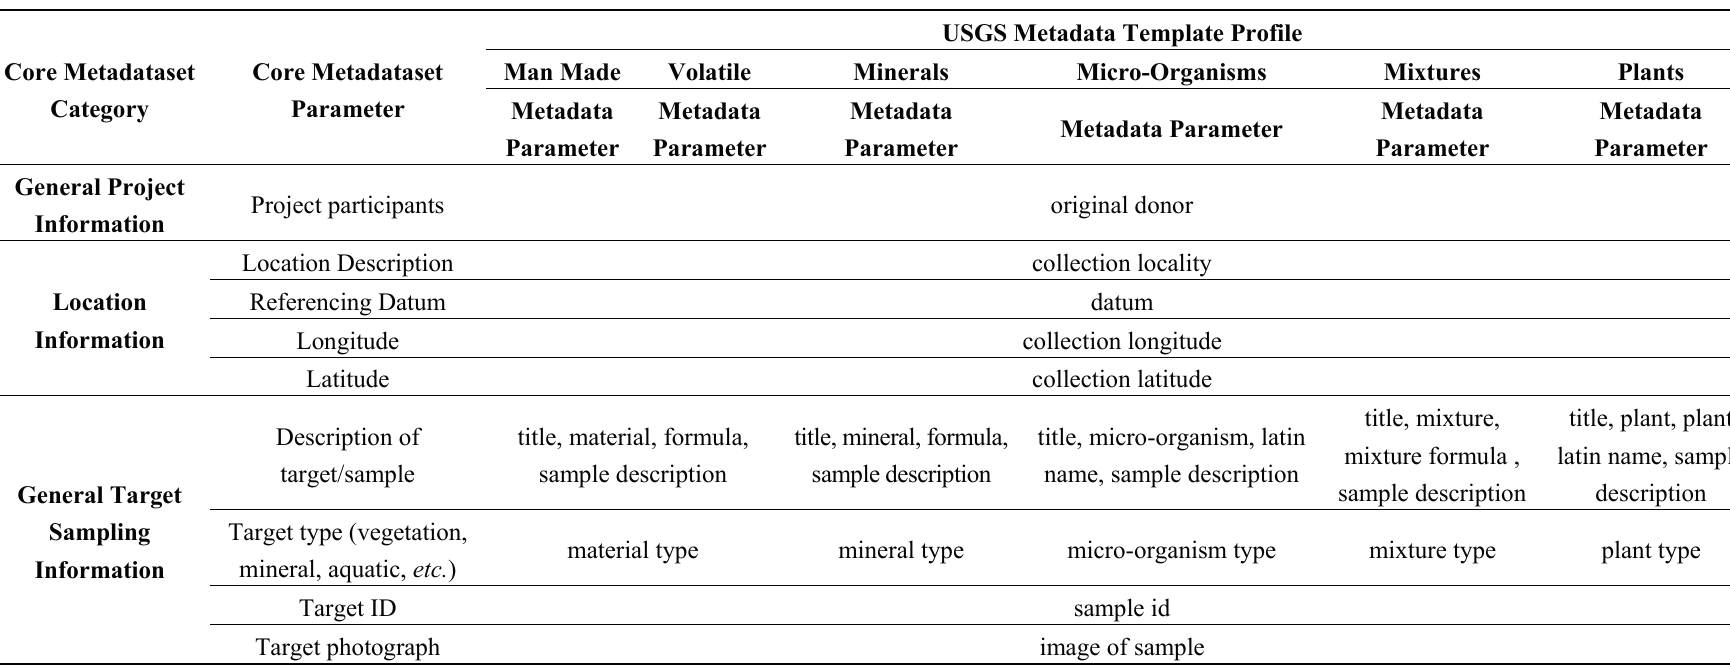
Table 3. Mappings between metadata elements in the Core metadataset and the USGS Spectral Library v. splib06a metadata template